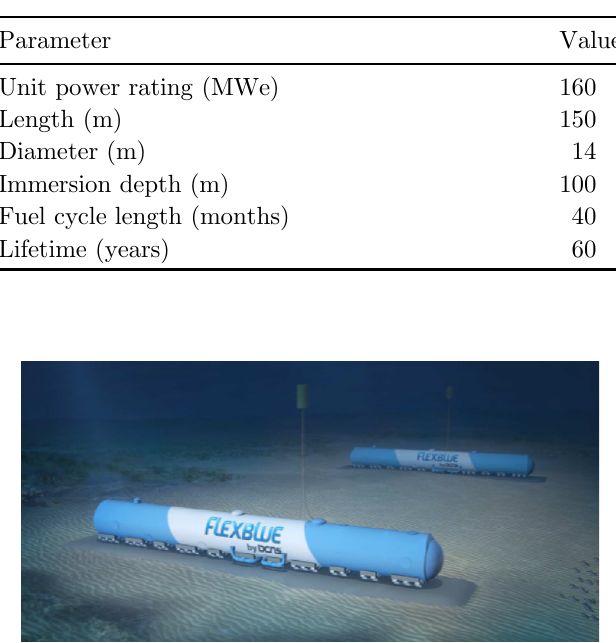
Table 2. Flexblue ® reactor characteristics.